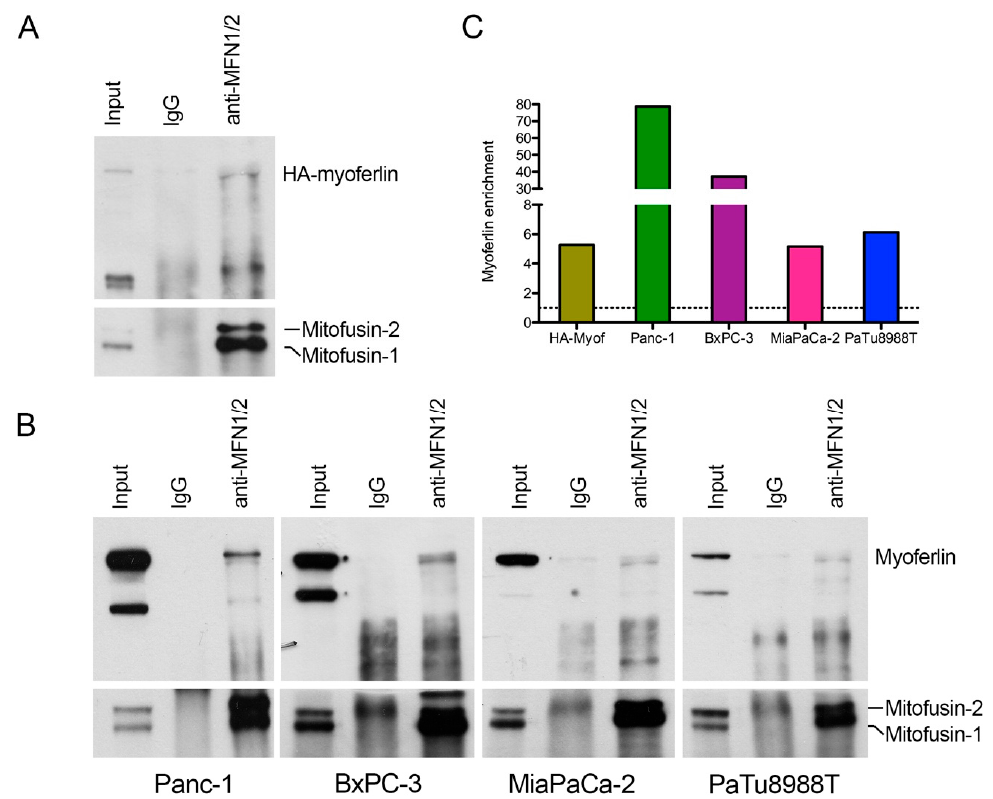
Figure 4. Myoferlin interacts with mitofusins in pancreas cancer cell lines. ( A ) coimmunoprecipitation of mitofusins and HA-tagged myoferlin with an anti-mitofusin antibody. Western blot of protein samples from whole cells (input), IgG control immunoprecipitation (IgG), and mitofusins immunoprecipitation (anti-MFN1 / 2) of HA-myoferlin transfected Panc-1 cells. HA-myoferlin and mitofusins were detected on the same membrane; ( B ) coimmunoprecipitation of mitofusins and endogenous myoferlin with an anti-mitofusin antibody. Western blot of protein samples from whole cells, IgG control immunoprecipitation, and mitofusins immunoprecipitation of Panc-1, BxPC-3, MiaPaCa-2, and PaTu8988T cell lines. Myoferlin and mitofusins were detected on the same membrane; ( C ) myoferlin (or HA-tagged myoferlin) enrichment in anti-MFN1 / 2 relatively to IgG. Quantification was performed using ImageJ. All experiments were performed as three independent biological replicates.